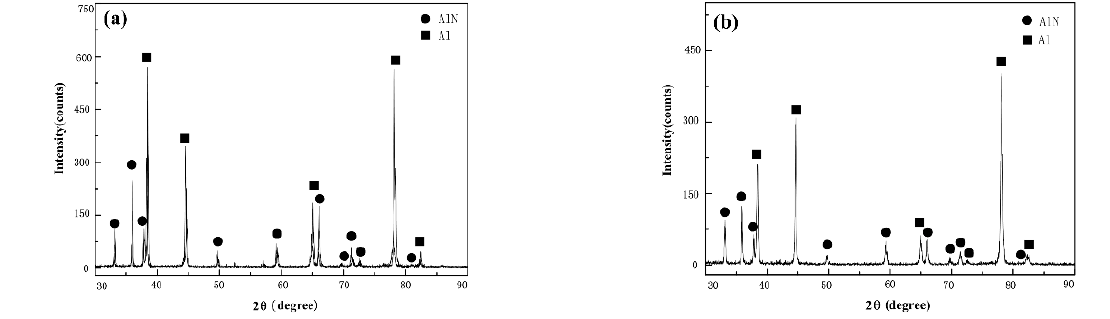
Figure 1. X-ray diffraction patterns of ( a ) AlN-6082 and ( b ) AlN-1060.